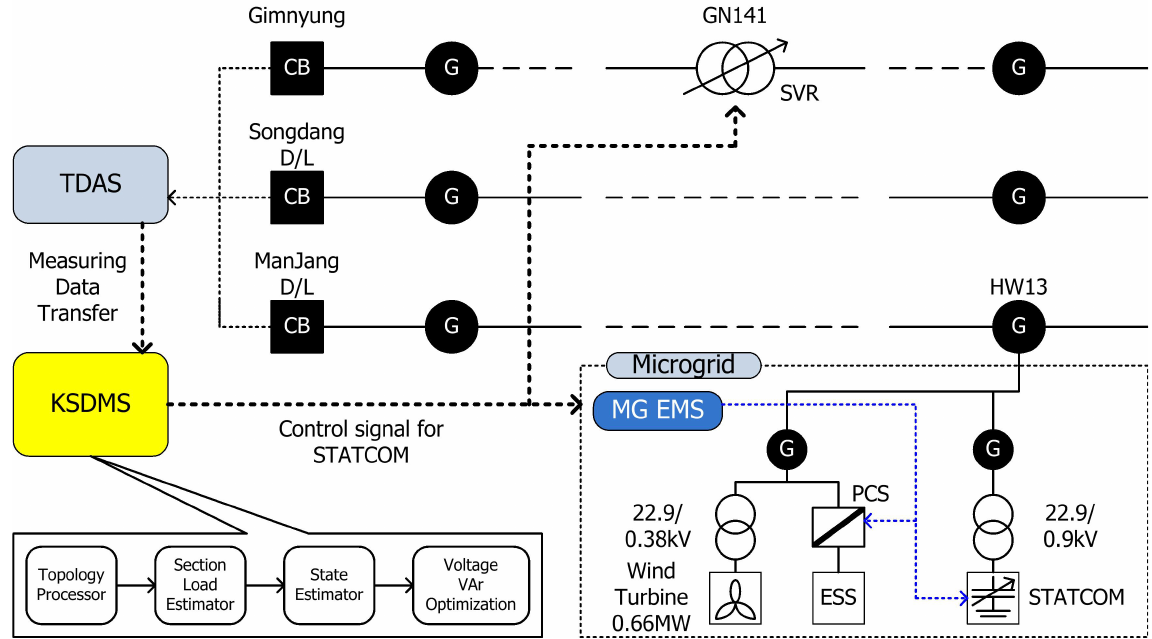
Figure 16. One-line diagram of the Jeju island field test